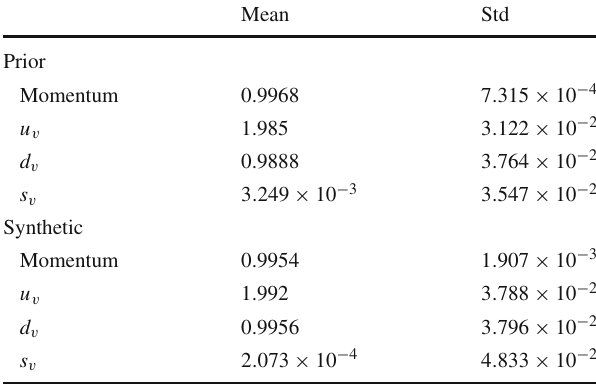
Table 2 Table comparing the values of the sum rules between the prior with N p = 1000 and synthetic PDF set with N s = 2000 generated from the prior using ganpdfs